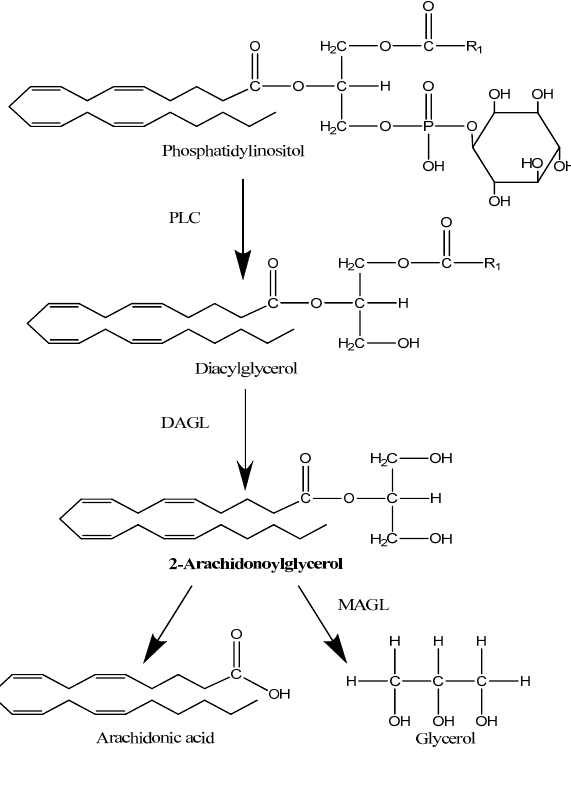
Figure 2. Main pathway for the synthesis and degradation of